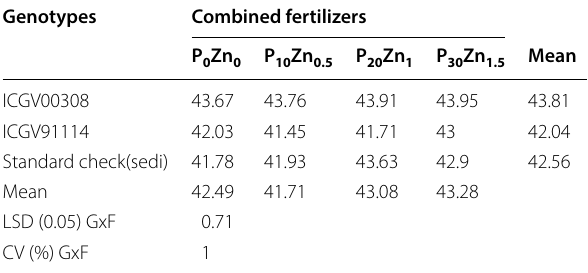
P kg/ha Zn g/L, LSD (0.05) least significant difference at 5% level; = = = CV coefficient of variation = Table 9 Correlation coefficients between the groundnut parameters as affected by genotypes and PZn combined fertilizers